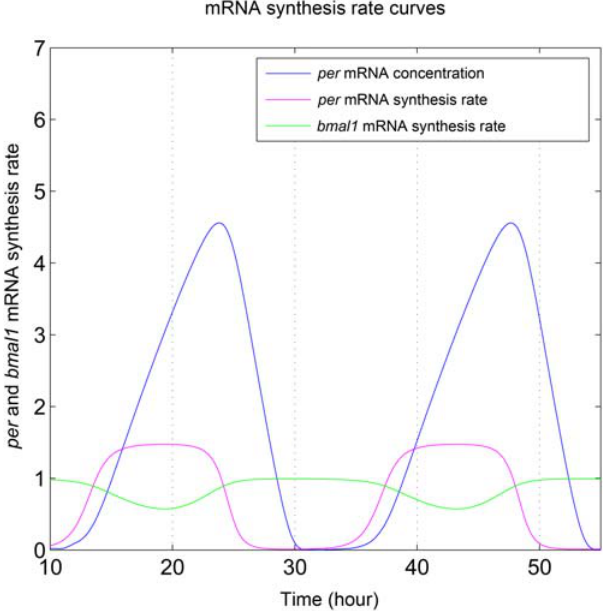
Figure 5. Per and Bmal1 mRNA synthesis rate curves.